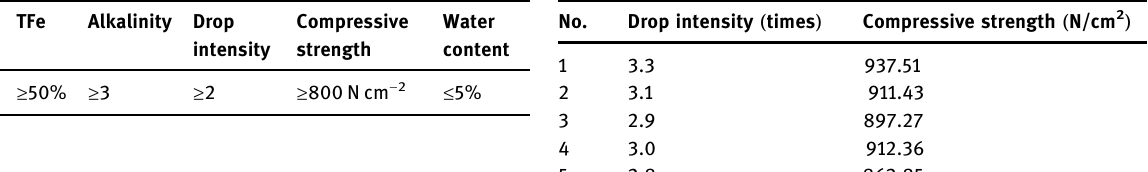
Table 11: The quality index of the converter slagging agent Index TFe